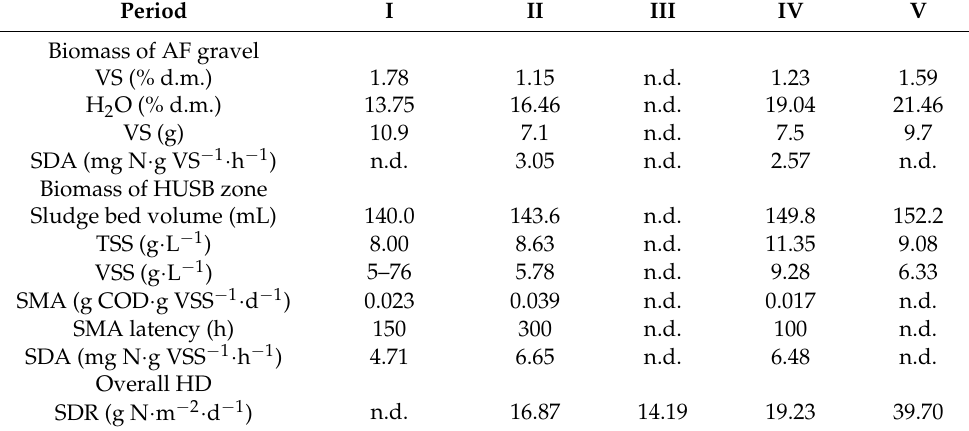
Table 3. Solid characteristics in both the HUSB zone and the filtering zone of the HD at the end of each operational